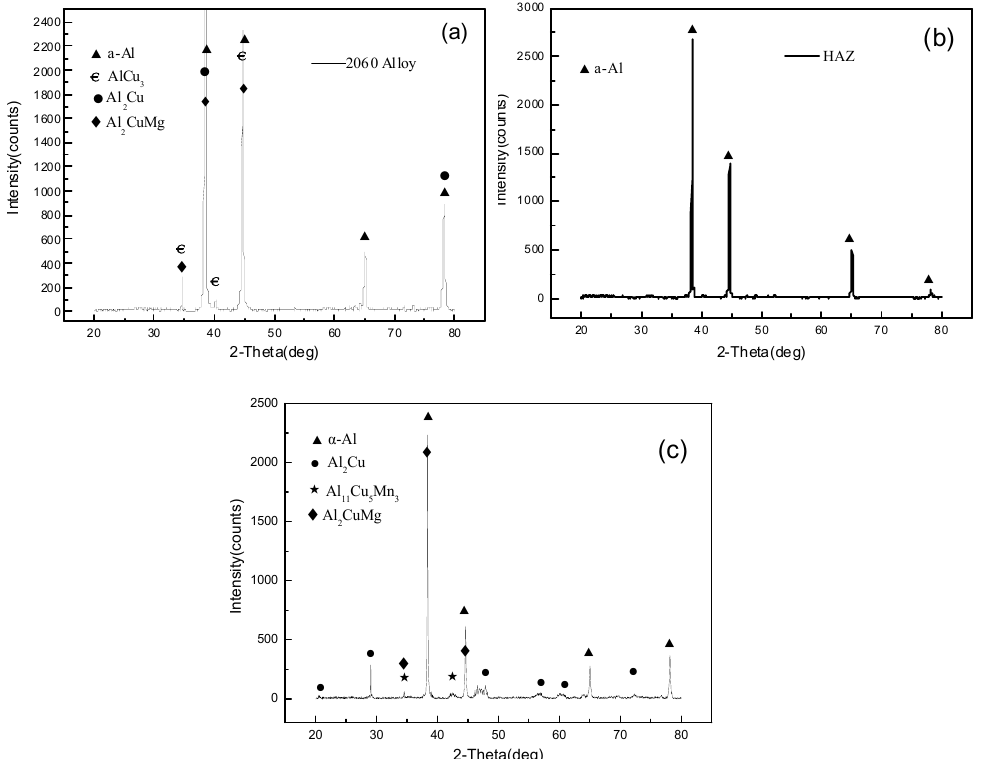
Figure 3. X-ray diffraction spectrum of the 2060 Al–Li alloy laser welding joint. ( a ) 2060 Al–Li alloy base metal; ( b ) HAZ; ( c ) weld metal.